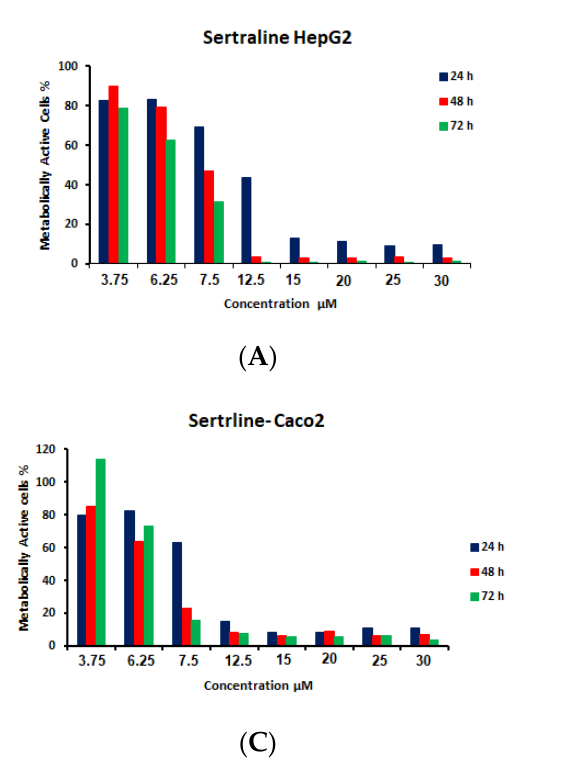
Figure 7. Cytotoxicity monitoring ( A ) sertraline against HepG2 ( B ) sertraline 10 mg/L after gamma irradiation towards HepG2 ( C ) sertraline towards Caco2 ( D ) sertraline 10 mg/L towards gamma irradiation towards Caco2.